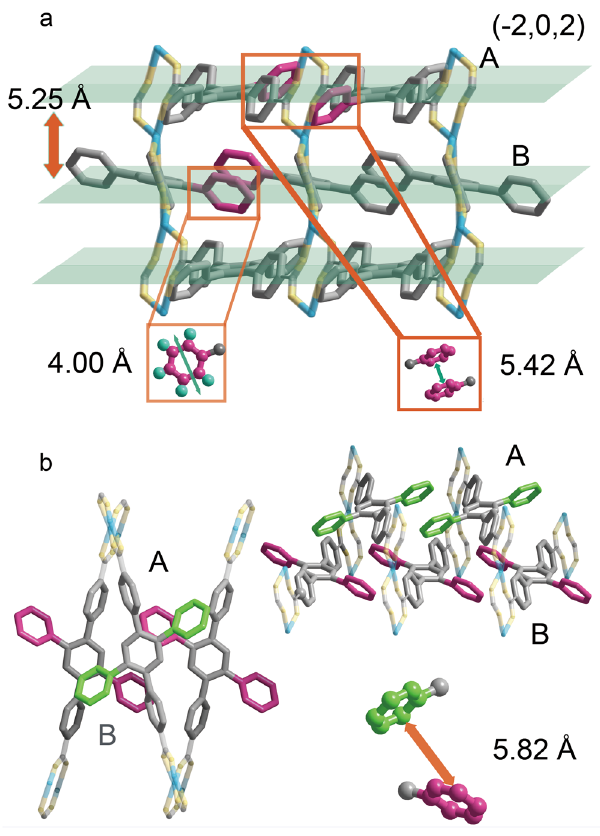
Fig. 5 Analysis of the structure of FJI-H31. a The distance between each paralleled ligand along with the ( − 2, 0, 2) face, the distance of adjacent ligands and the distance of rotating diameter . b The ABAB stacking mode of ( − 2, 0, 2)